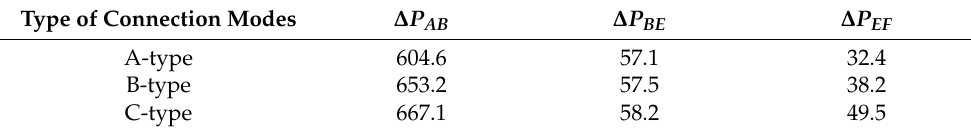
Table A2. Pressure drop across furnace, cyclones, and connection (Theory, unit of